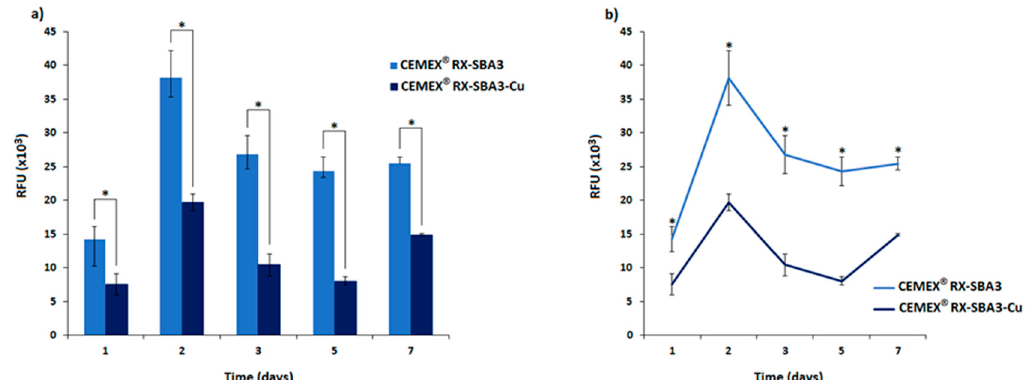
Figure 8. ( a ) CEMEX ® RX and CEMEX ® RX-Cu antibacterial activity towards S. epidermidis biofilm.